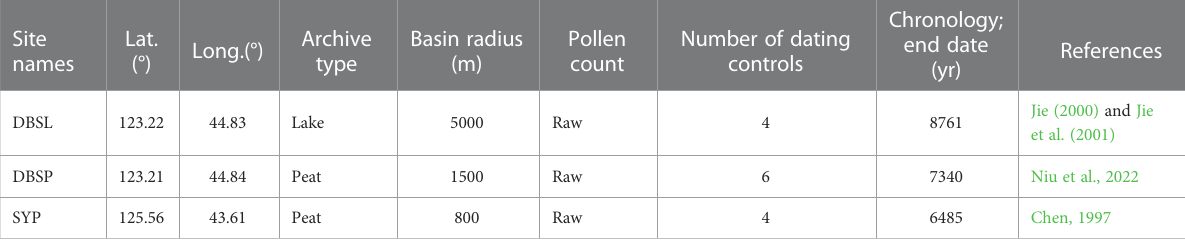
TABLE 1 Metadata (we choose the modern basin size for REVEALS modelling in this study).